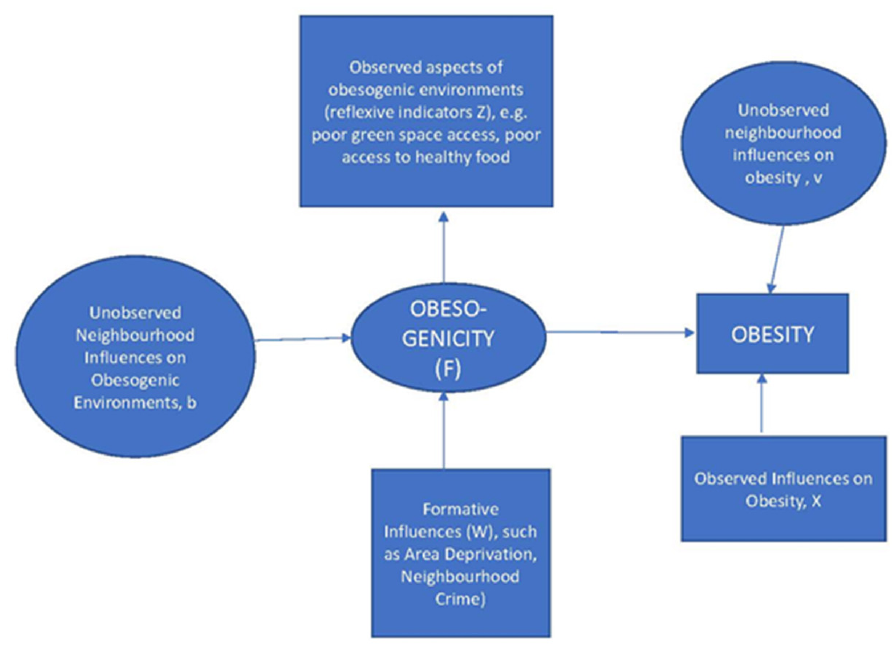
Figure 1. Diagrammatic Representation of Postulated Influences on